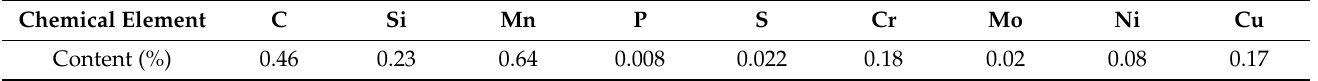
Table 2. Chemical composition of steel C45E.